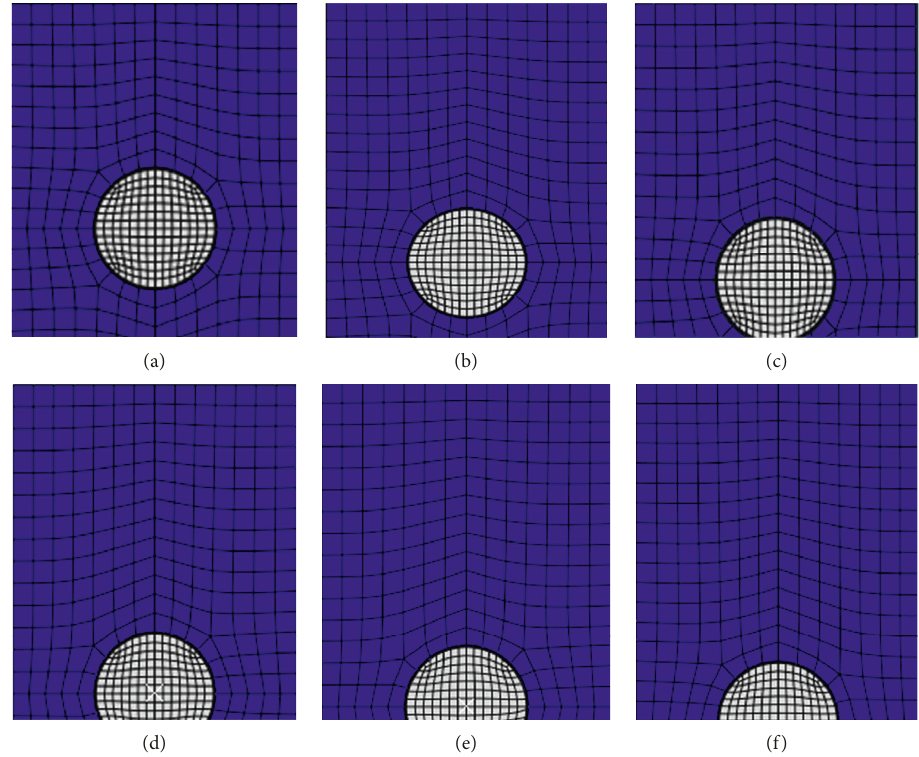
Figure 10: Finite element model of different rubber thickness. (a) 4.0mm, (b) 5.0mm, (c) 5.5mm, (d) 6.0mm, (e) 6.5mm, and (f) 7.0mm.